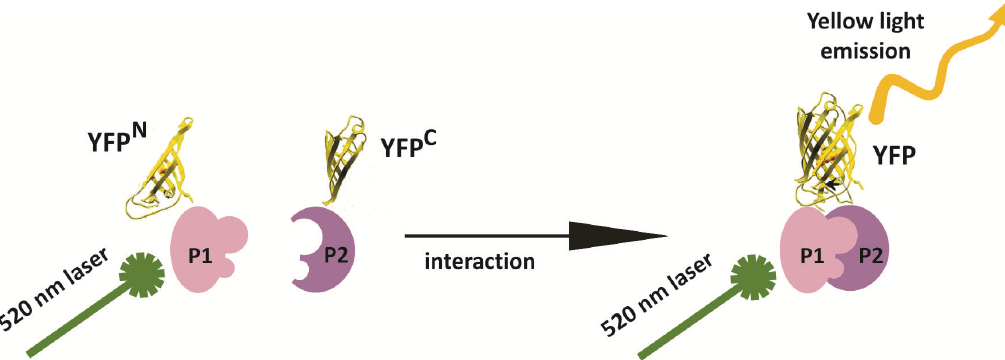
Figure 1. Schematic representation of the split-YFP (yellow fluorescent protein)/BiFC (bimolecular fluorescence complementation) method based on the YFP. YFP is split into two non-fluorescent “halves”, an N -terminal part/half of the protein (YFP N ) and a C -terminal part/half of the protein (YFP C ), which are then fused to the proteins of interest (P1 and P2). The YFP molecule is reconstituted upon interaction between P1 and P2, resulting in yellow fluorescence when the molecules are excited with the correct